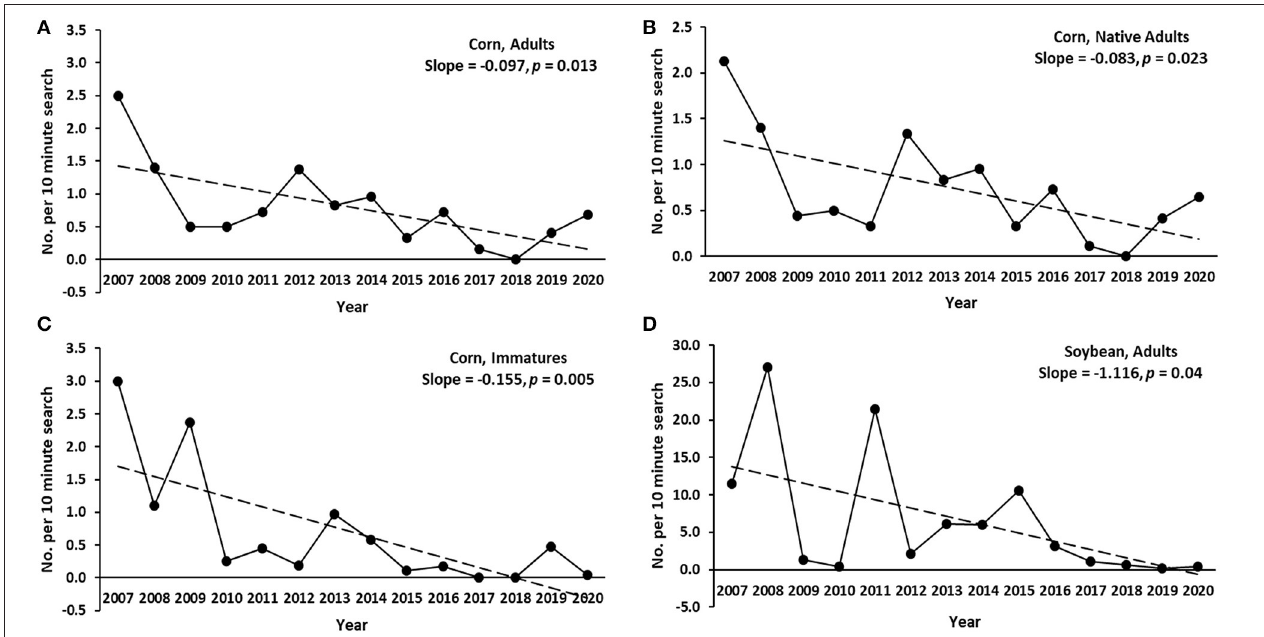
FIGURE 1 | Significant declining trends in annual coccinellid abundance (average no. of coccinellids per 10-min search) in corn and soybean in east-central South Dakota, with slopes and p- values of linear regressions for the respective trend lines. (A) Corn, adults across species. (B) Adults of native species. (C) Corn, immatures (larvae and pupae) across species. (D) Soybean, adults across species.